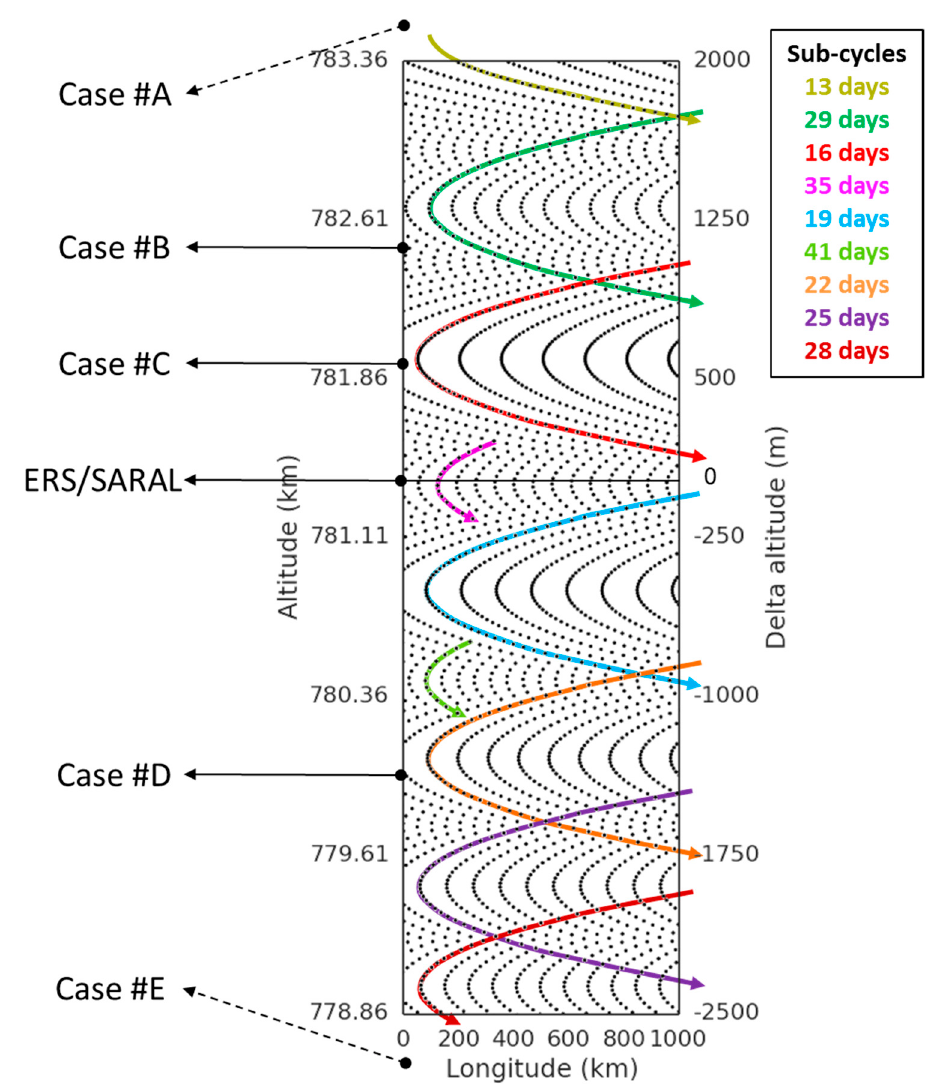
Figure 4. Simulated longitude of the AltiKa ascending tracks over a 15-year period. The simulation starts 2 km above the ERS orbit and it decreases by approximately 300 m per year. The continuously decreasing altitude transforms the orbit repeat cycle and sub-cycles (highlighted as colored parabolas): the 3-day sub-cycle of this altitude range generates composite sub-cycles increasing by 3 days (e.g., 13, 16, 19, 22, 25, 28), and the intermediate sub-cycles compose higher level sub-cycles (e.g., 29-day from 13 and 16, or 35 from 16 and 19). The circle alignment of the 5 panels in Figure 3 is explained by the colored parabolas.